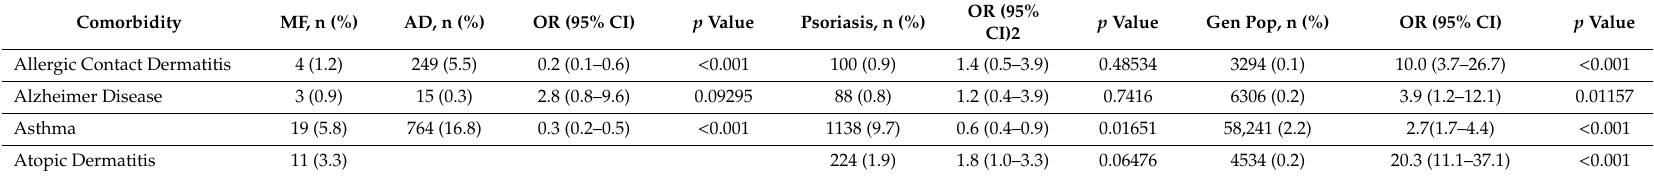
Table A3. Absolute number, percentage, odds ratios and p values of White / Caucasian patients age 18 years and older with mycosis fungoides (MF) and various comorbid conditions, as compared with race-matched controls age 18 years and older with AD, with psoriasis, or within the general population who were seen at the JHHS between January 1, 2013 and January 1, 2019. Data presented for 329 patients with mycosis fungoides (MF), 4545 patients with AD, 11,700 patients with psoriasis, and 2,671,135 patients in the general population (excluding those with MF). AD, Atopic dermatitis; COPD, chronic obstructive pulmonary disease; OR, odds ratio; PN, prurigo nodularis; IBS, inflammatory bowel